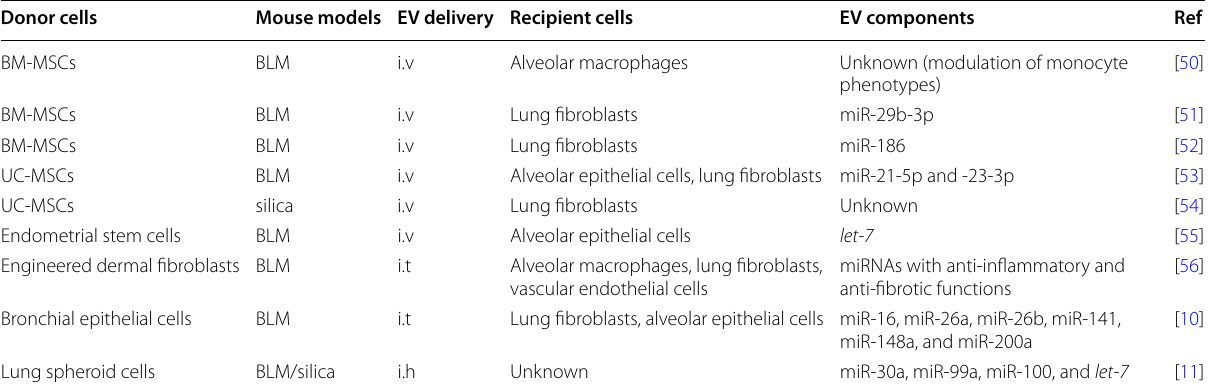
BM-MSCs bone marrow mesenchymal stem cells, UC-MSCs umbilical cord mesenchymal stem cells, BLM bleomycin, i.v intravenous, i.t intratracheal, i.h inhalation